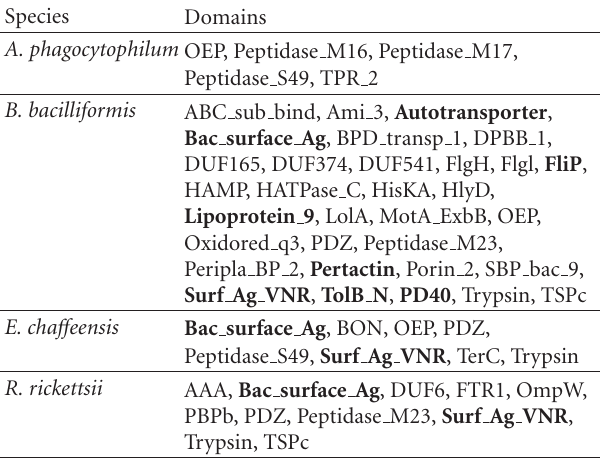
Table 3: Domains associated with secreted CFPs in four species of arthropod-borne